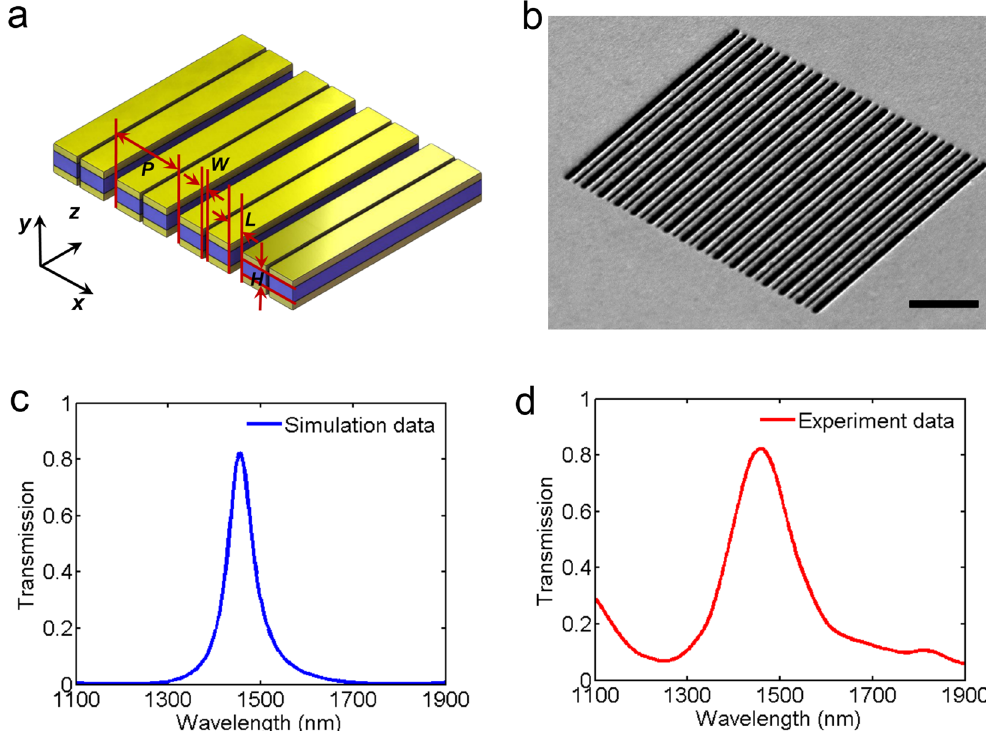
Figure 4. Narrow-band plasmonic bandpass filter constructed by free-standing dual-slit MDM stack array. ( a ) Schematic diagram of the free-standing dual-slit MDM stack array. The dual-slit array is formed by piercing periodic narrow slits of width W = 80 nm on the structure of Fig. 1(a). Other structure parameters are identical to that in Fig. 1(a). ( b ) SEM images of the fabricated dual-slit device. Scale bar, 4 μ m. ( c ) Calculated and ( d ) measured transmission spectra for the free-standing dual-slit MDM stack array.